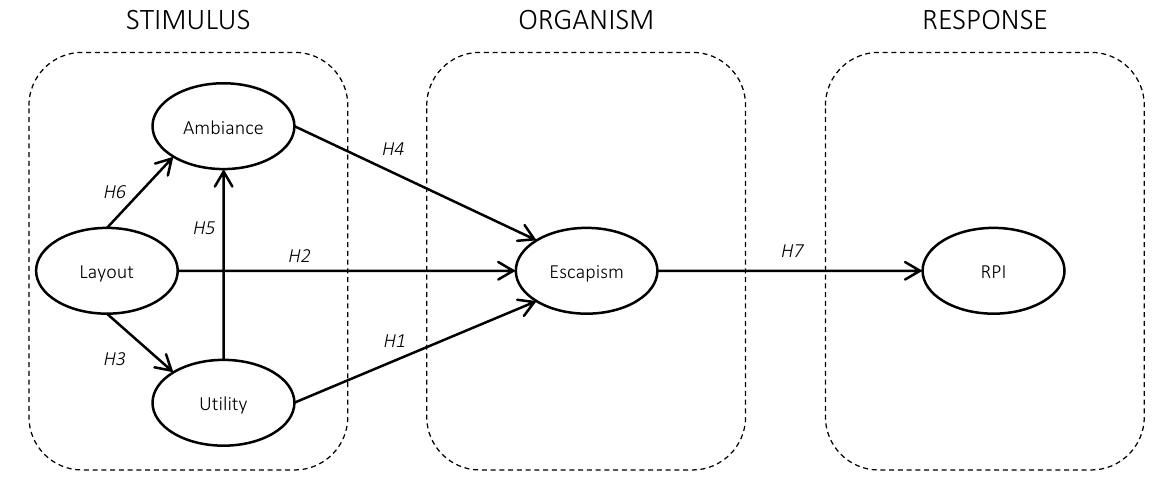
Figure 1. Projected